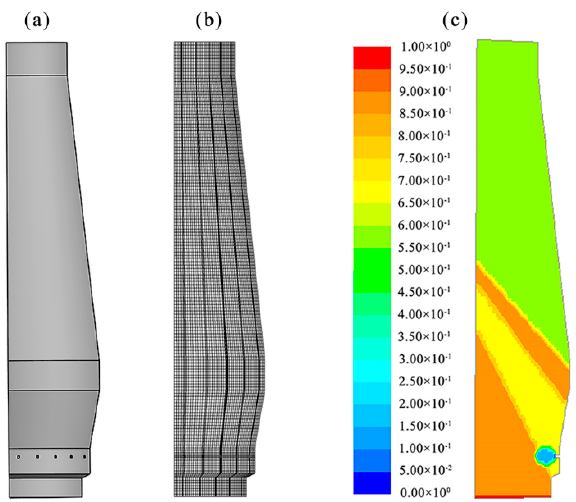
Figure 1. Geometric and mesh models and volume fraction distribution of solid phase of blast furnace B in Bayi Steel of Baowu Group ( a ) geometric model; ( b ) mesh model; ( c ) volume fraction distribution of solid